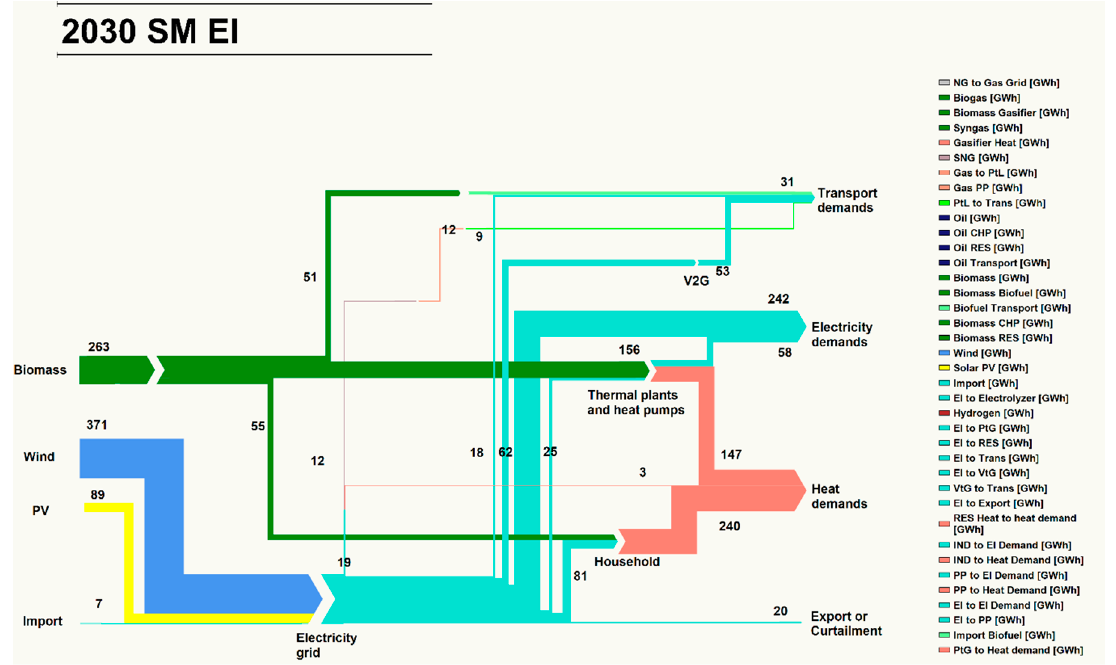
Figure 1. Simplified annual energy flows (in GWh) for the 2030 SM El scenario. Data source: [23].